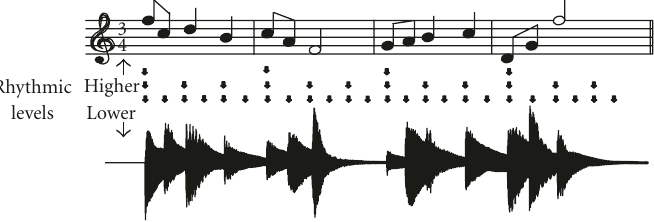
Figure 1: Example showing how the rhythmic structure of music can be decomposed in rhythmic levels formed by equidistant pulses. There is a double relationship between the lowest rhythmic level and the next higher rhythmic level, on the contrary there is a triple relationship between the highest rhythmic level and the next lower level.